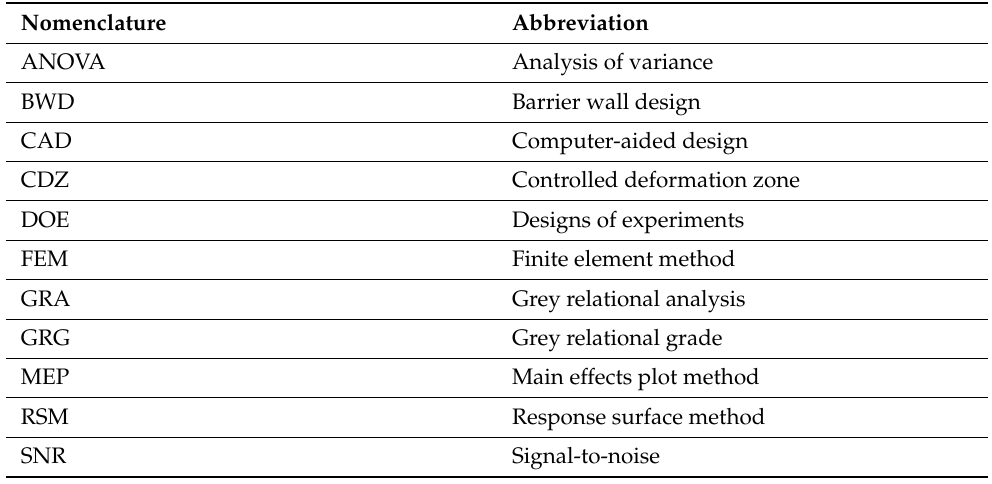
Table 2. Nomenclature and abbreviations used in this study.